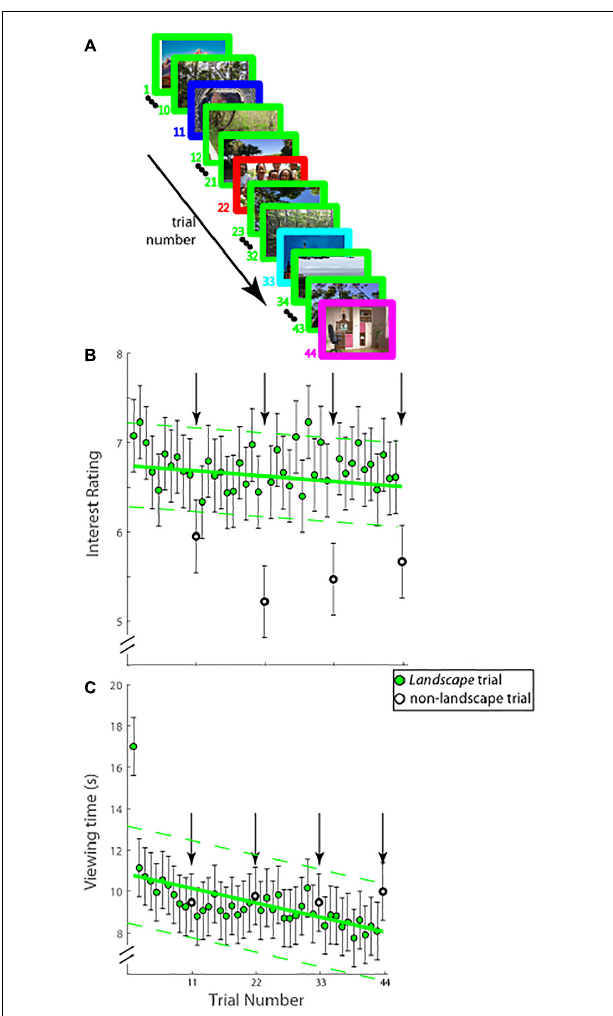
FIGURE 3 | (A) Schematic of experimental paradigm (Experiment 2B). On each trial (44 trials total), an image was displayed on the screen and observers viewed it for as long as they desired. Interest ratings were obtained as in Experiments 1 and 2A. Images from landscapes were shown on all trials (green border) except on trial numbers 11, 22, 33, and 44 (borders not colored green), on which images from one of the remaining four categories was shown. (B) Interest ratings on a ten-point scale (mean ± SEM; ordinate) and (C) viewing time in seconds; (mean ± SEM; ordinate) as a function of trial number (abscissa) are shown. Group landscape trial data were fitted with a least-squares linear function (solid green lines) and its 95% confidence interval (dotted green lines). Trial numbers 11, 22, 33, and 44 are shown in open circles and arrows, and were not used in determining the fit.